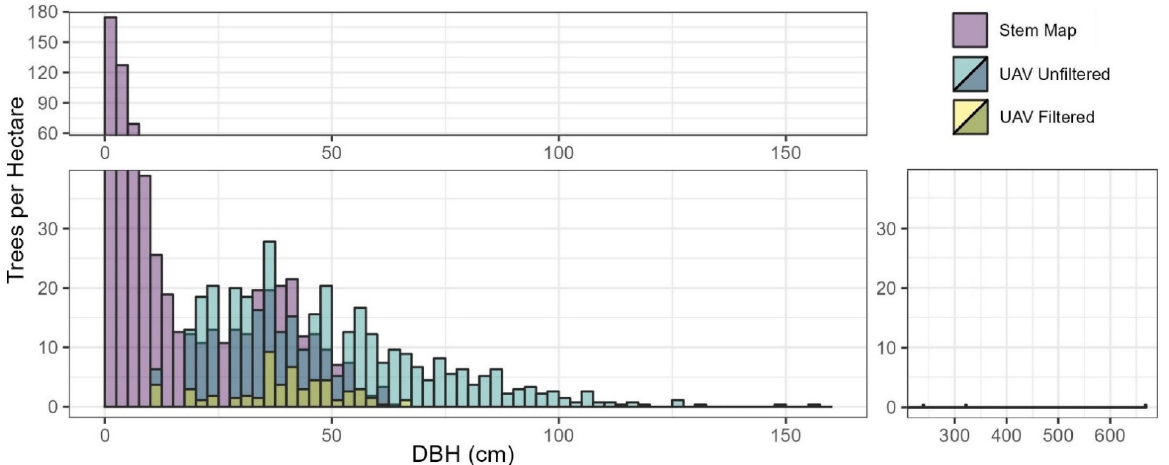
Figure 4. Distribution of stem mapped and SfM extracted DBH values, unfiltered and filtered.